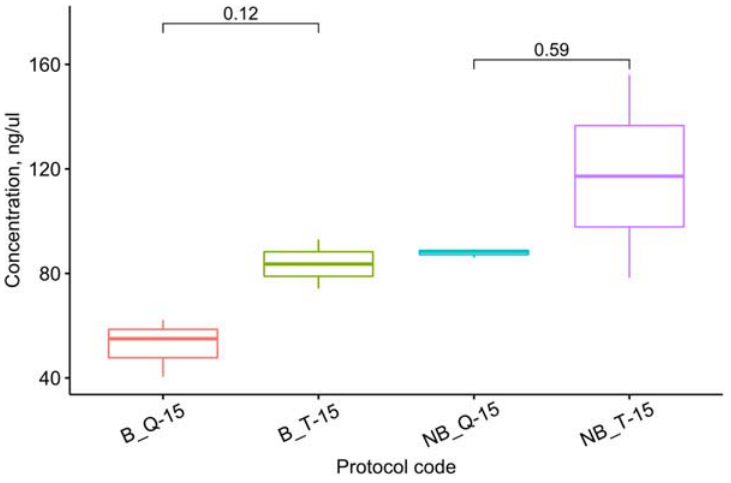
Figure 4. Effects of the extraction method on the RNA concentration of the samples ground in the buffer for 15 s. The letters up to “_” denote the grinding method: MP–mortar and pestle, NB–Tissue Lyser without buffer, and B–with buffer. The following letters denote the isolation protocol: T–TRIzol, Q–RNEasy Plant Mini Kit, and TQ–a combination (Table 1). The number after “-” denotes the grinding time on the Tissue Lyser in seconds. The t -test p -values are given for each pair of methods discussed in the text.